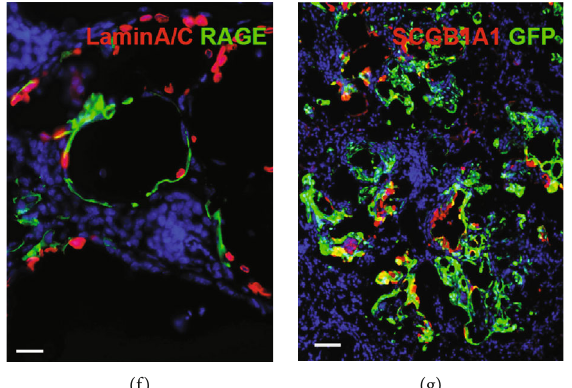
Figure 5: Alveolar regeneration by intrapulmonary transplantation of hDASCs. (a) Bright fi eld and direct fl uorescent images of the chimeric lung after GFP+ hDASC transplantation. (a1) Mock-transplanted. (a2) Uninjured lung. (a3) GFP-labeling hDASCs transplanted. (b) Immuno fl uorescence images of the chimeric lung of anti-Lamin A/C (red) with DNA counterstain (DAPI, blue). Scale bar, 1000 μ m. (c, d) Immuno fl uorescence images of the chimeric lung with GFP and human-speci fi c Lamin A/C and hDASC marker KRT5 Abs. Scale bar, 200 μ m. (e, f) Immuno fl uorescence images of the chimeric lung with human-speci fi c Lamin A/C and AEC1 marker AQP5 and RAGE. Scale bar, 30 μ m. (g) Immuno fl uorescence images of the chimeric lung with human-speci fi c Lamin A/C and SCGB1A1. Scale bar, 50 μ m.